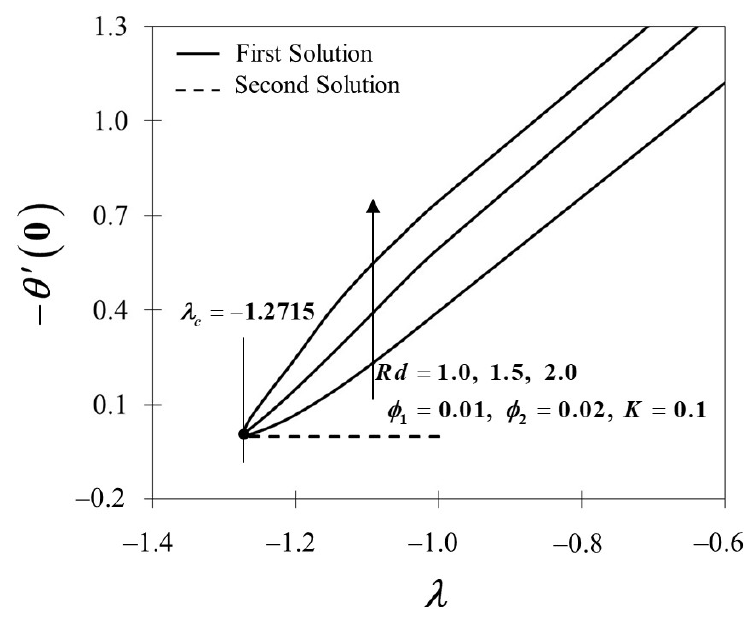
Figure 11. − θ (cid:48) ( 0 ) towards λ by assorted Rd .